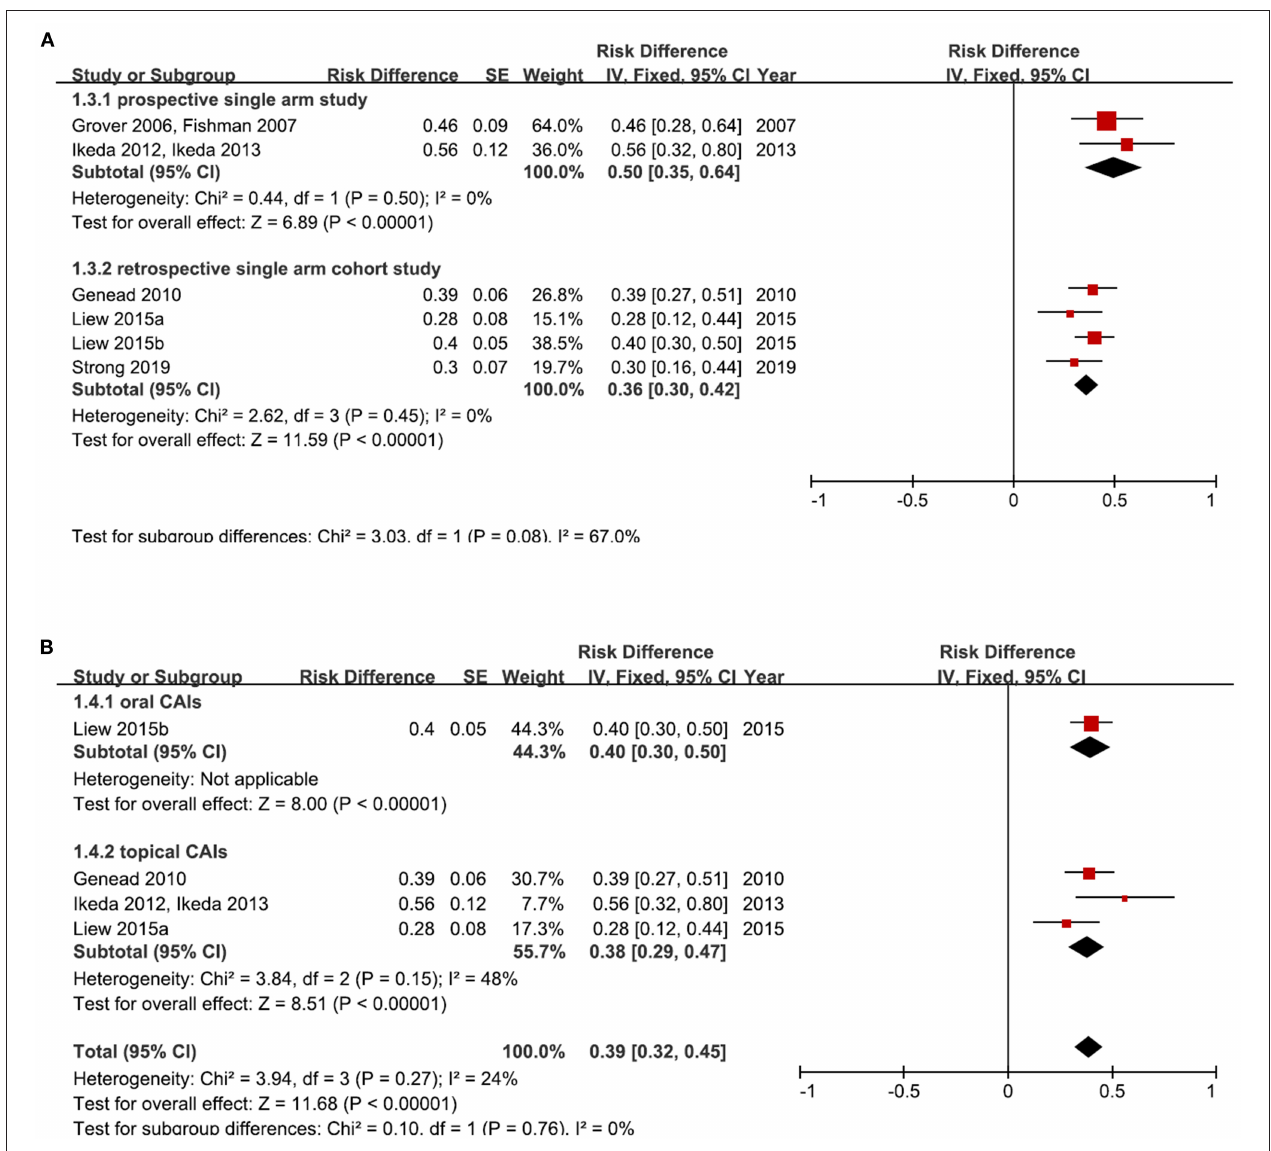
FIGURE 5 | Forest plots for the meta-analysis of the responder proportion after carbonic anhydrase inhibitors (CAIs) treatment . (A) Meta-analysis of different study types; (B) Subgroup analysis according to different administration methods of CAIs. [Ikeda et al. defined the responder as CMT decreased 20% from baseline. We calculated the 11% decrease of CMT from their published original data; The responder rate of the study Grover et al. (30)/Fishman and Apushkin (7) was calculated from their published original data; Other studies reported the 11% reduction rate directly] [*the study Strong 2019 was used for analysis in (A) but not in (B) because oral and topical CAIs treatment data cannot be separated in this study. The study Grover et al. (30)/Fishman and Apushkin (7) was used for analysis in (A) but not in (B) because this study may share some same patients with the study Genead and Fishman